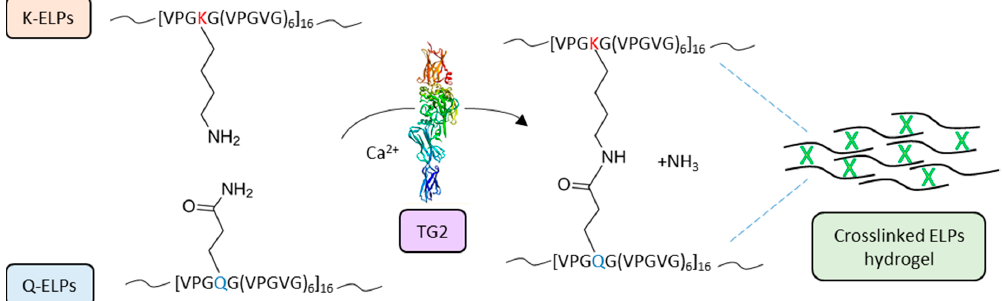
Figure 4. Schematic representation of TG2-crosslinked ELPs hydrogels. The repeat sequence [VPGXG(VPGVG) 6 ] 16 of ELPs was genetically designed to produce two libraries by substituting the X residue with Lys (K) and Gln (Q), thus generating K-ELPs and Q-ELPs, respectively. TG2 mediates the formation of a crosslink between the Gln and Lys residues of ELPs [191]. The Q and K side chains are superimposed to visualize the TG reaction. TG2 three-dimensional structure (PDB: 2Q3Z) was produced with the molecule modelling software, “EzMol” [34].